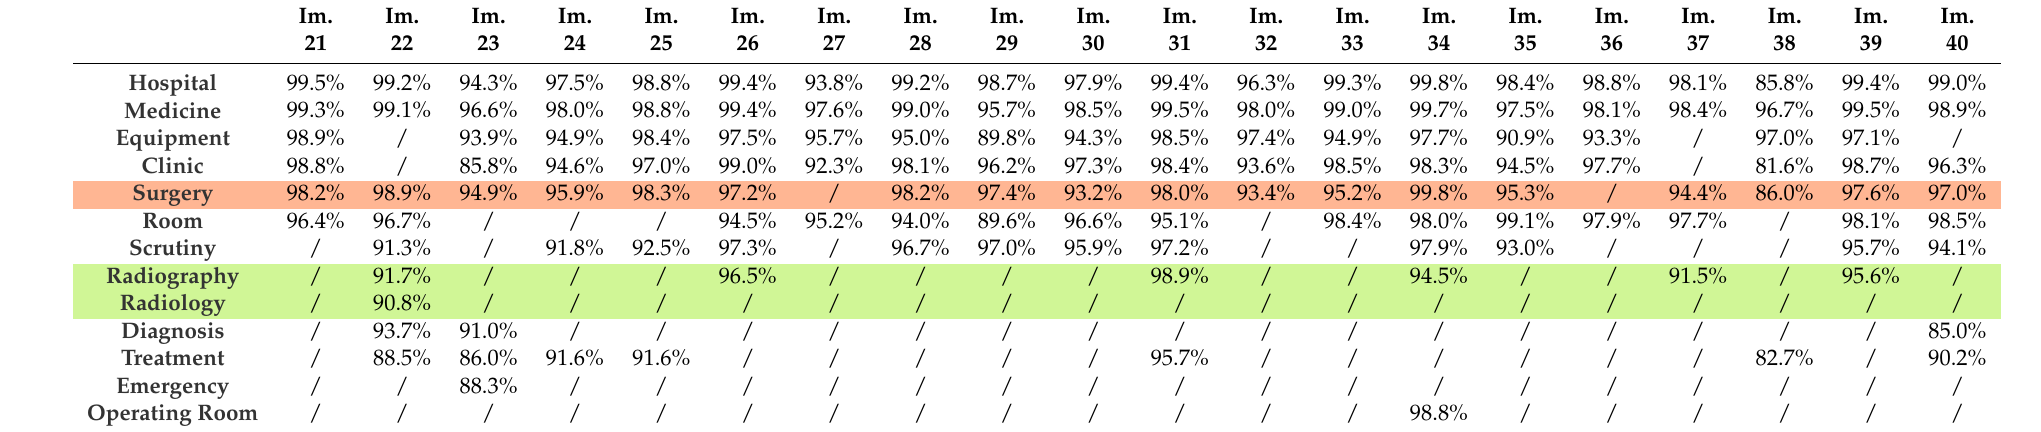
Table A2. Percentage of confidence obtained with the Clarifai General Model for the “radiology” IU. Each column corresponds to Image 21 to 40. Im. 21